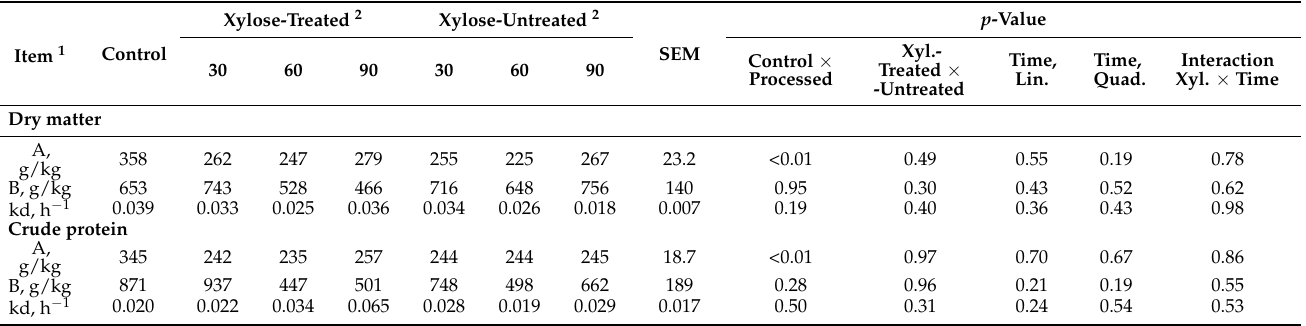
Table 5. Effects of conventional oven heating and xylose inclusion on the rumen degradation parameters of peanut meal.